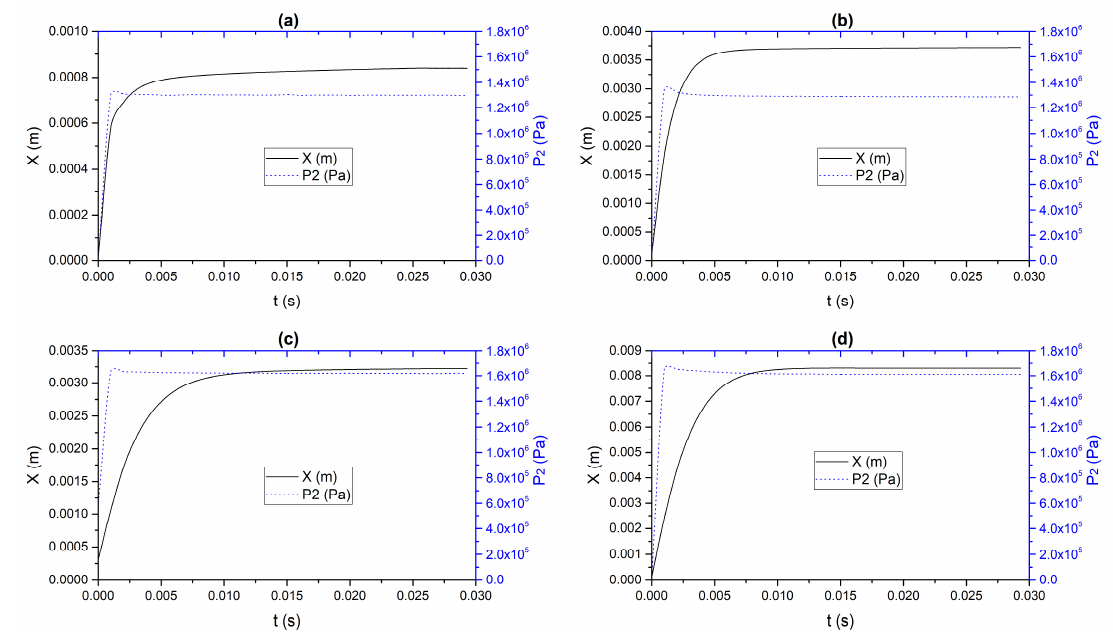
Figure 6. Development of poppet displacement X (left-side y -axis) and outlet pressure P 2 (right-side y -axis) during the start-up for: ( a ) q e = 5 L / s and P 1 = 1.2 MPa; ( b ) q e = 10 L / s and P 1 = 1.2 MPa; ( c ) q e = 5 L / s and P 1 = 1.6 MPa; ( d ) q e = 10 L / s and P 1 = 1.6 MPa.